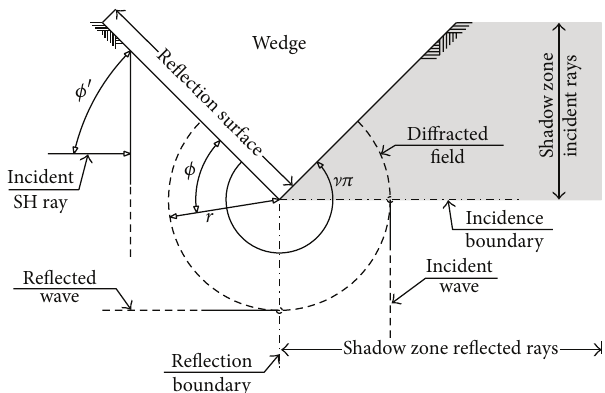
Figure 2: Elementary wedge forming the basis of the SBD approach. The incident ray corresponds to a plane SH front impinging against an infinite wedge. As the incident front is reflected by the free surface zones illuminated by the incident and reflected rays develop. However, ahead of the illuminated free surface, the absence of incident and reflected rays forms a shadow zone. The boundary resulting in between the illuminated and shadow zone corresponds toaregionofdiscontinuityoftheincomingfield;howevercontinuity is restored by a cylindrical diffracted wave that penetrates into the shadow zone and generated by the point